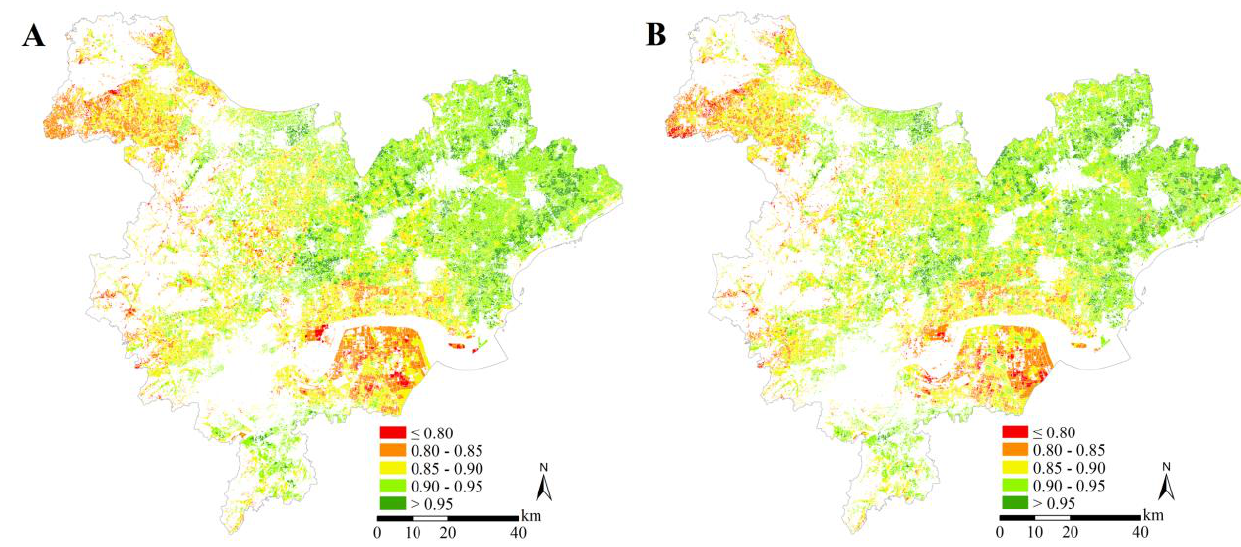
Figure 3. The distribution of cultivated land quality in 2020 (A) and 2017 (B).